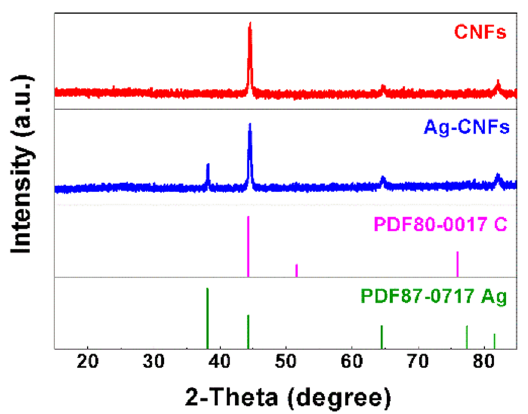
Figure 1: XRD patterns of CNFs and Ag -